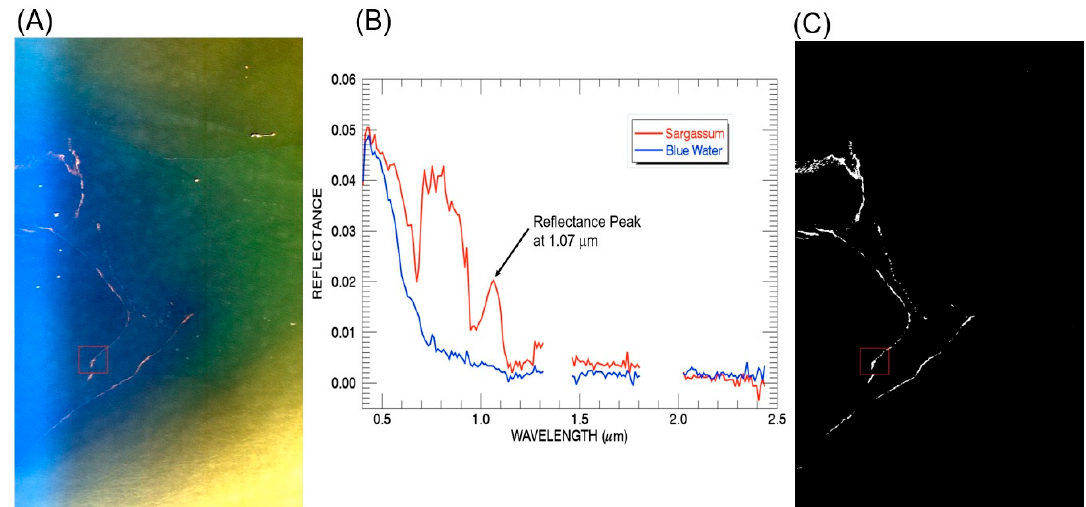
Figure 4. ( A ) A true color RGB image from an AVIRIS data set measured over the Gulf of Mexico in the west of the Mississippi Bird-Foot Delta at UTC 1425 on 24 May 2010; ( B ) A reflectance spectrum of a Sargassum pixel, and that of a nearby clear water pixel; ( C ) The floating vegetation mask.